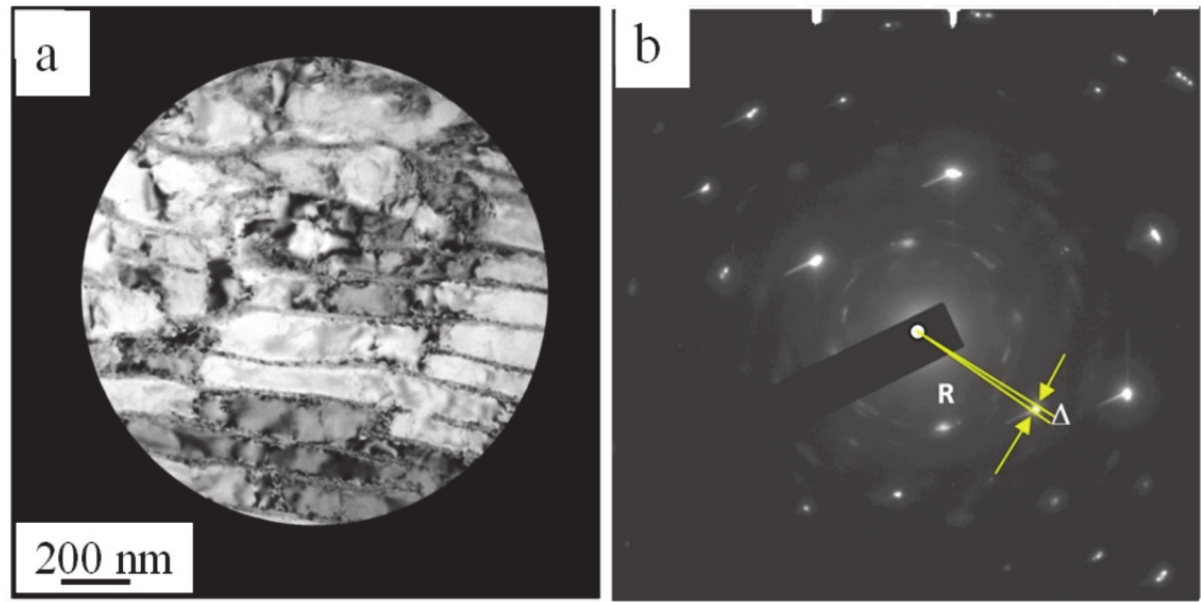
Figure 6. A TEM image of the steel structure ( a ); ( b )—the microelectron diffraction pattern obtained from the given foil portion. The arrows indicate the reflection determined by azimuthal components of the whole disorientation angle of the steel structure.